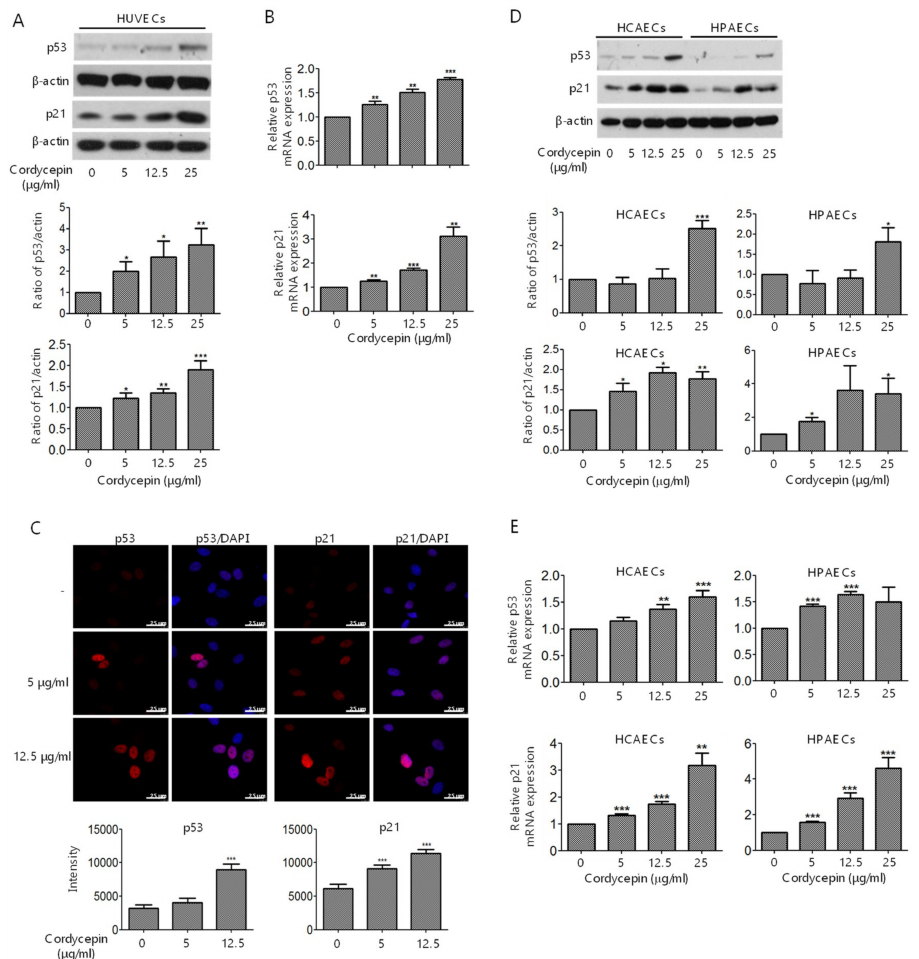
Figure 5. Induction of p53 and p21 expression in ECs by cordycepin. ( A , D ) HUVECs, HCAECs, and HPAECs were treated with 0–25 µ g/mL cordycepin for 24 h. The expression levels of p53 and p21 were determined by western blotting analysis. ( B , E ) HUVECs, HCAECs, and HPAECs were treated with 0–25 µ g/mL cordycepin for 4 h. The expression levels of p53 and p21 were determined by qPCR. ( C ) HUVECs were treated with 0–12.5 µ g/mL cordycepin for 24 h. The expression levels of p53 and p21 were determined by confocal microscopy. β -actin was used as the loading control. Scale bars: mean ± SD. *, p < 0.05; **, p < 0.01; ***, p <